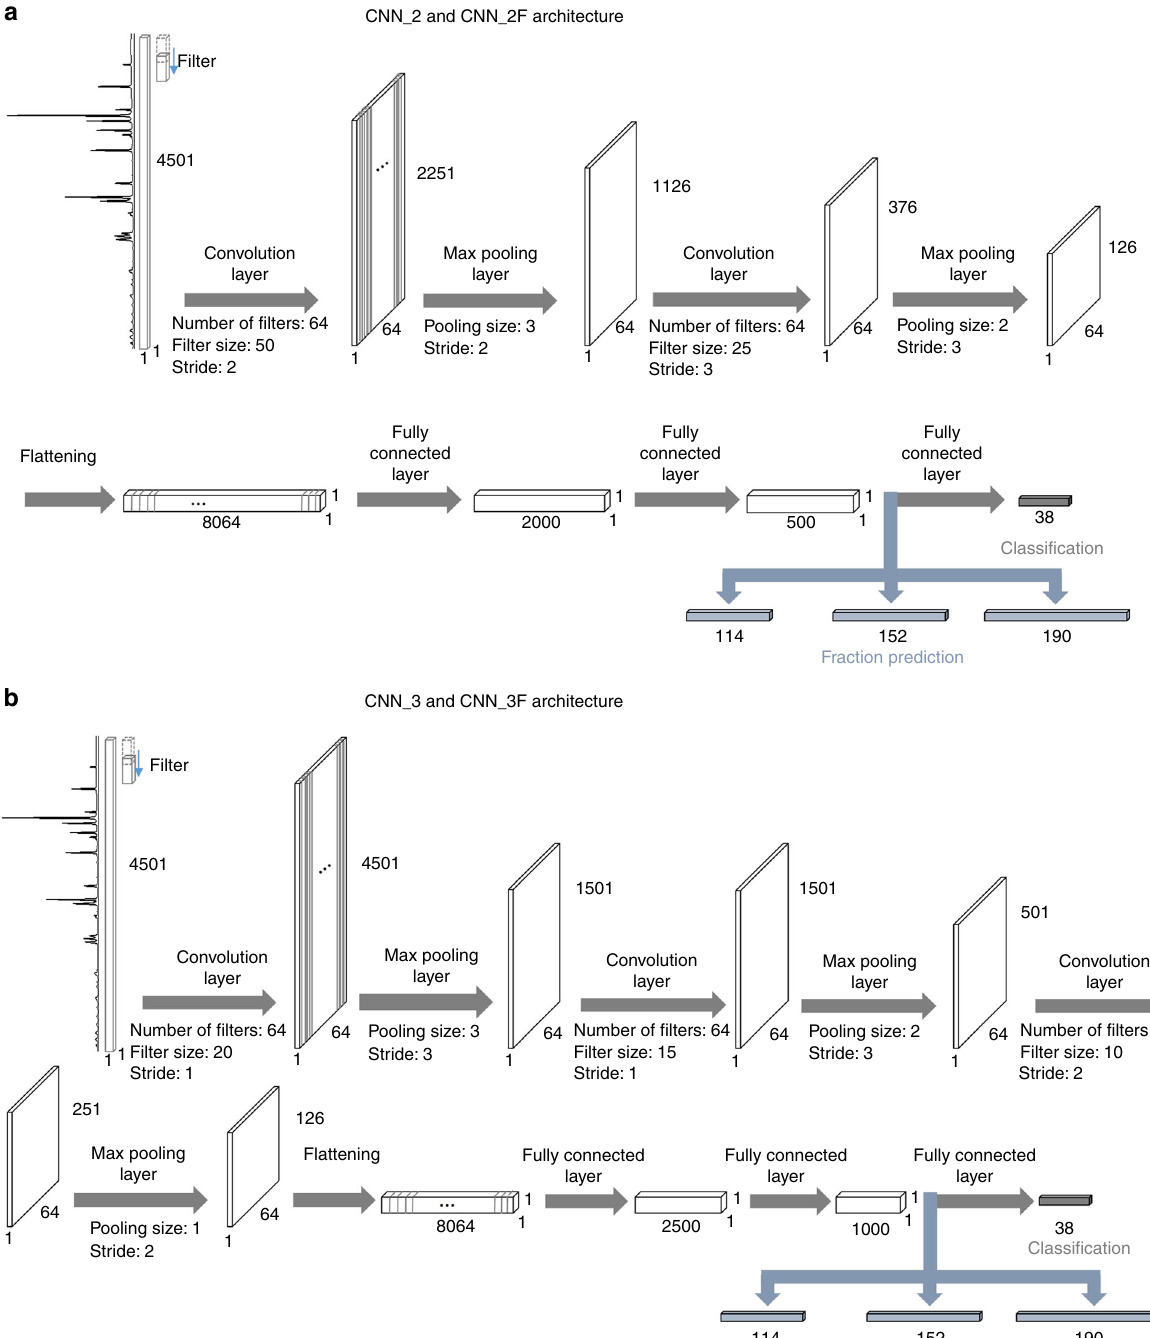
Fig. 4 The schematic representation for CNN architectures. a CNN_2 and b CNN_3 architectures, which consisted of two and three convolution/max pooling layers, respectively. Three ensuing fully connected common layers followed. The number of fi lters, the kernel size, the pooling size, the stride, and the padding scheme are also given. The padding type was the “ SAME ” for all CNNs. Other deeper architectures such as CNN_4F, CNN_5F, and CNN_6F are schematically described in Supplementary Fig.